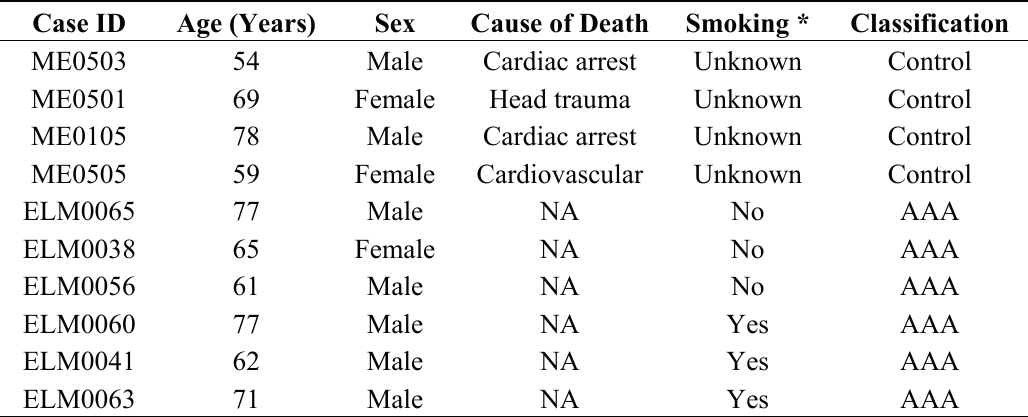
Table 2. Human aortic tissue samples used for immunohistochemical analysis.